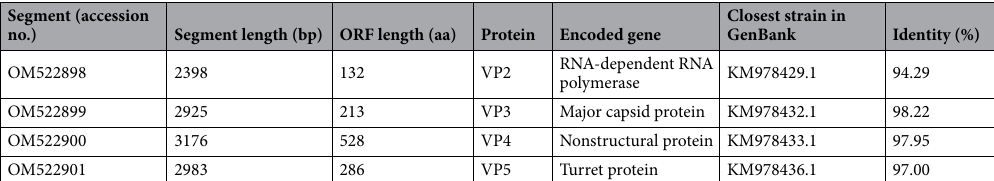
Table 2. Genome characterization of Fako virus genome described in this